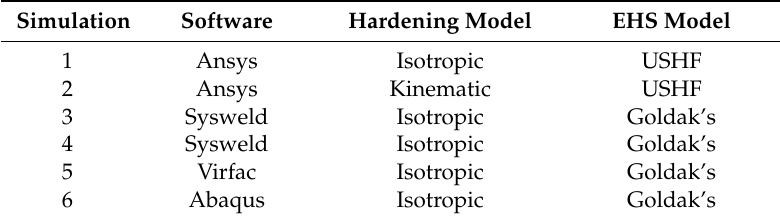
Table 5. Simulation matrix from [5] for two models: Hardening and Equivalent heat source (EHS).